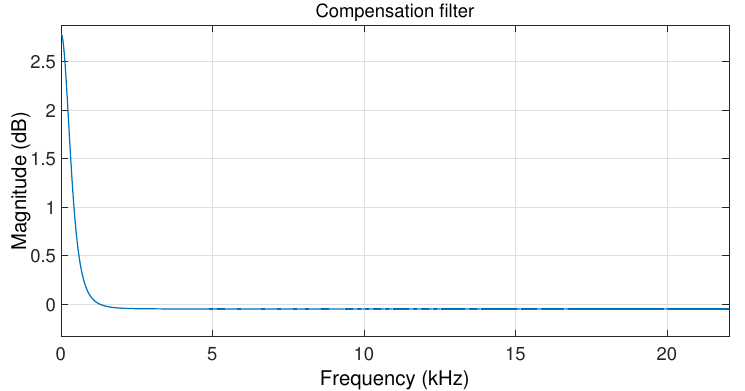
Figure 9. Magnitude of the compensation filter for pitch shifting an F 3 note (172.6 Hz) of a male singer to be pitch shifted a fifth